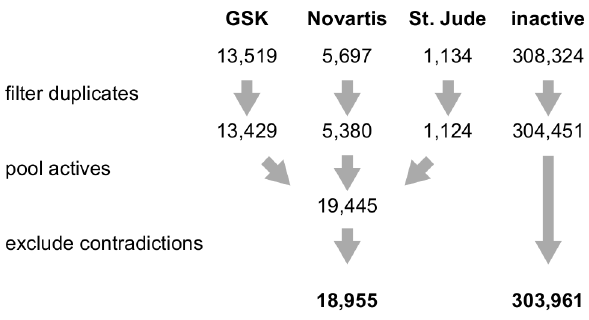
Figure 7. Data work-flow and library sizes during pre- processing of virtual target